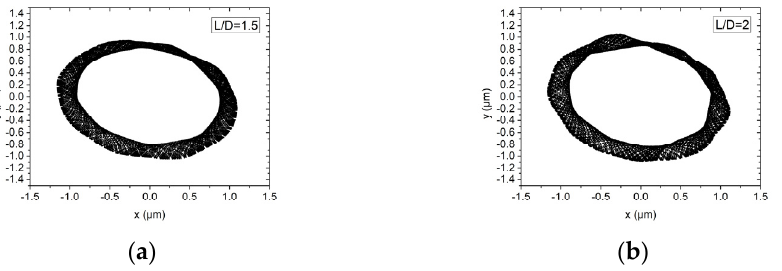
Figure 15. Rotor center trajectory under different L/D under working condition 5 (high speed, dynamic unbalance G1). ( a ) Rotor center trajectory ( L/D = 1.5), ( b ) rotor center trajectory ( L/D = 2).